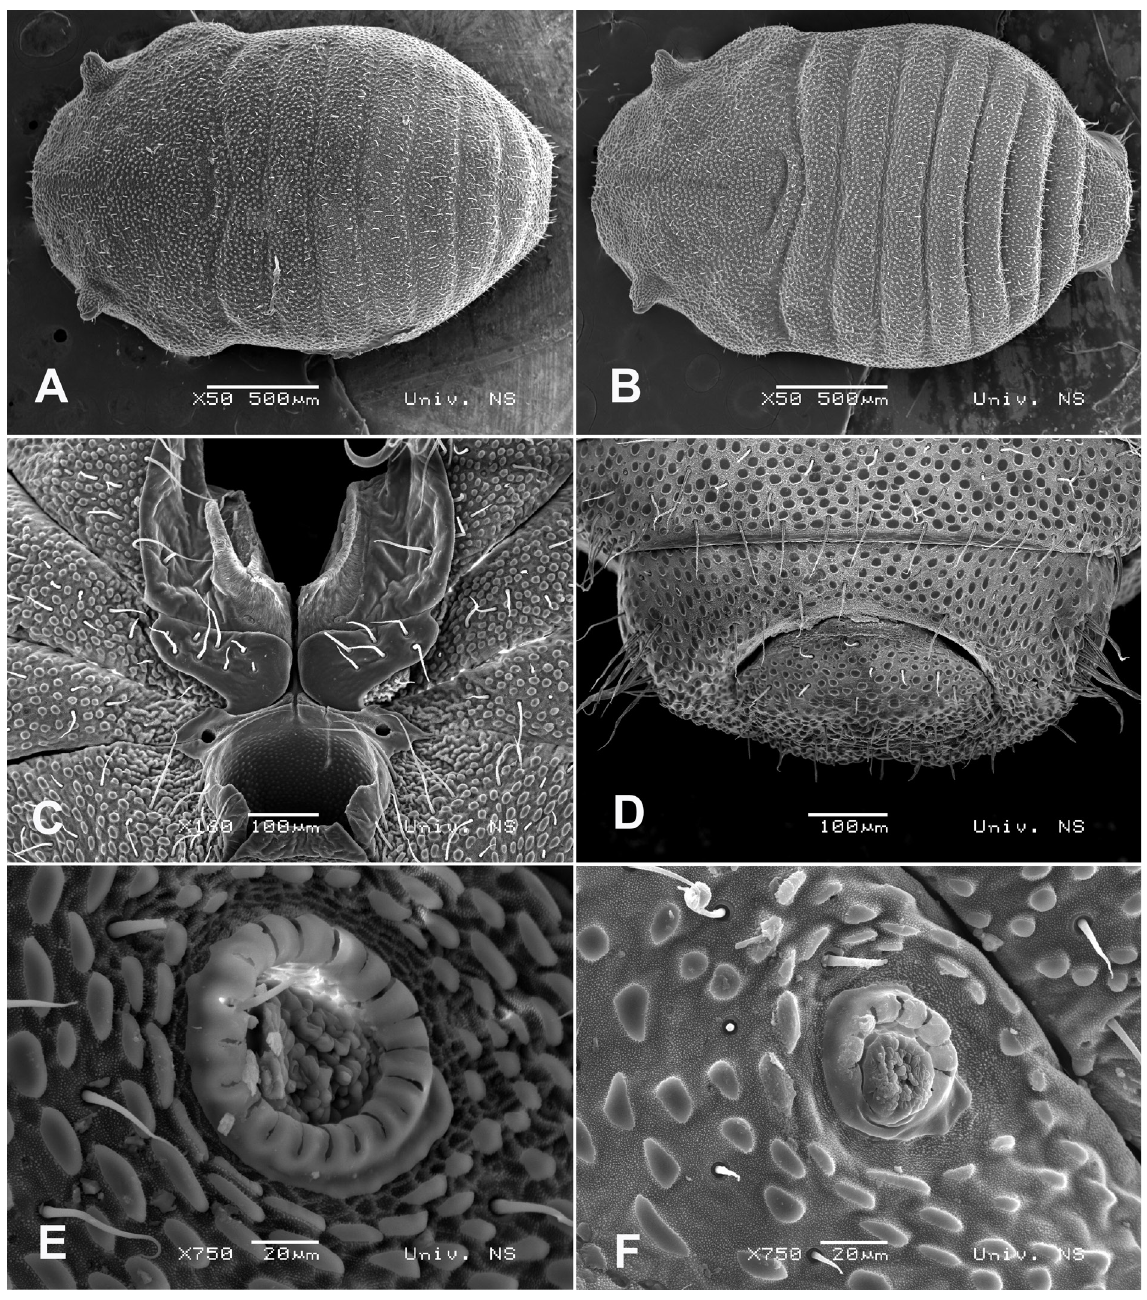
Fig. 8. Siro ozimeci Karaman sp. nov. A . Paratype, ♂ ( GMV 100067). B–E . Holotype, ♀ (GMV 100066). F . Siro franzi Karaman & Raspotnig sp. nov. (IKC1538). A–B . Dorsum. C . Ventral prosomal complex. D . Anal region, ventral view. E–F .